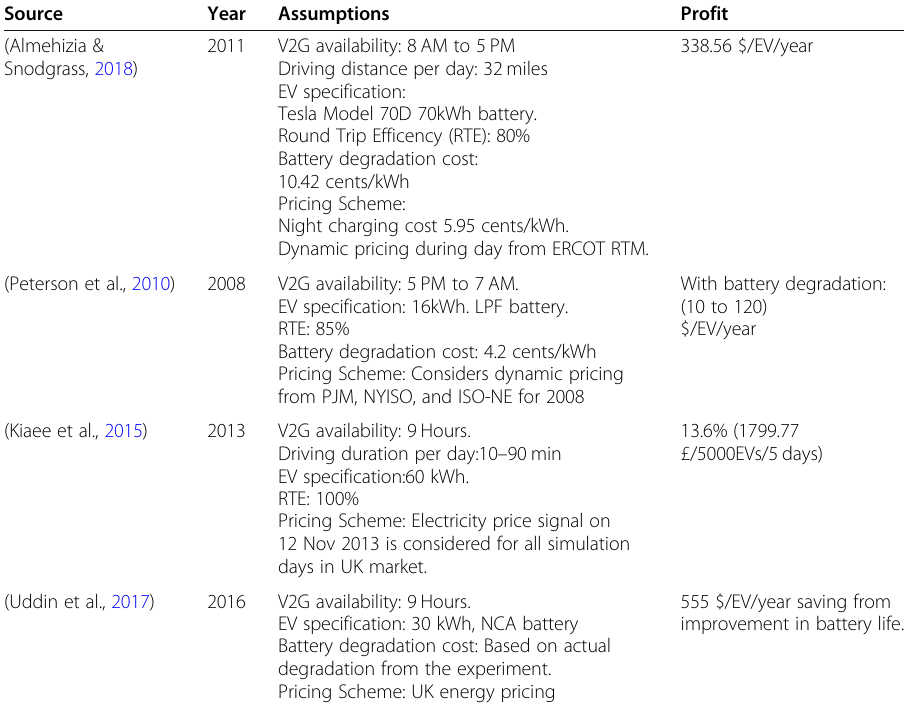
Table 1 State of the art economic models for V2G energy arbitrage Source Year Assumptions